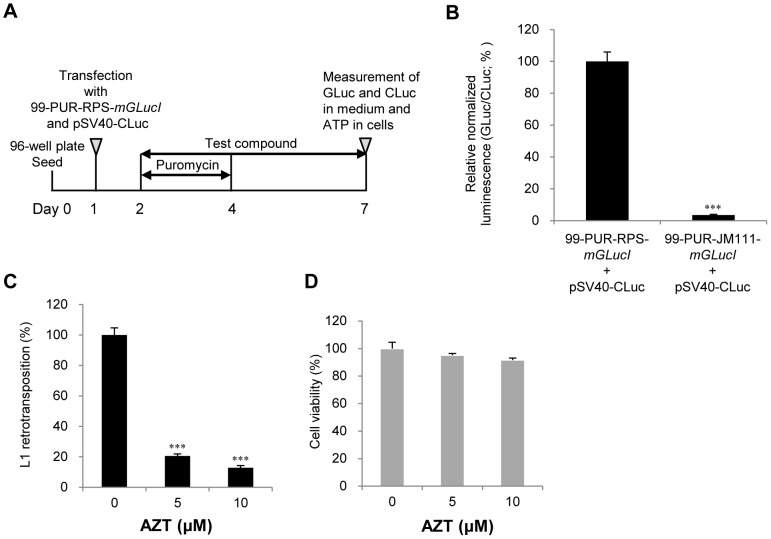
The dual secreted luciferase L1 retrotransposition assay.(A) Timeline of dual secreted luciferase L1 retrotransposition assay. HeLa cells transfected with 99-PUR-RPS-mGLucI and pSV40-CLuc were exposed to a test compound and puromycin for 2 days. The cells were then exposed to the test compound alone for an additional 3 days. GLuc and CLuc luminescence in the medium and cellular ATP were measured with a luminometer. GLuc luminescence indicates L1 retrotransposition activity. CLuc luminescence was used for normalization as an internal control. Cell viability was evaluated by cellular ATP content. (B) Effect of JM111 (L1RP ORF1 mutant) on L1 retrotransposition activity. Either 99-PUR-RPS-mGLucI or 99-PUR -JM111-mGLucI containing two missense mutations in L1RP ORF1 and pSV40-CLuc were co-transfected. L1 retrotransposition activity is represented as normalized luminescence. ***p<0.001. (C, D) Effect of the reverse transcriptase inhibitor azidothymidine (AZT) on L1 retrotransposition activity (C) and cell viability (D). L1 retrotransposition activity and cell viability are indicated as the percentage of the vehicle control. Data in (B–D) are the mean (± SD) from four independent experiments and are expressed relative to each control. ***p<0.001.